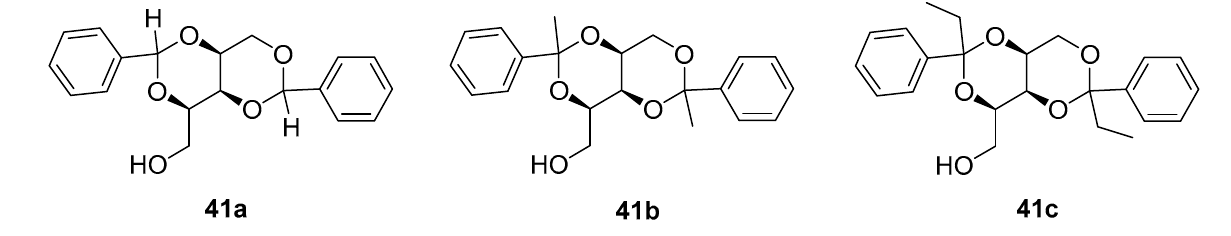
Figure 29. Xylitol based organogelators [76].